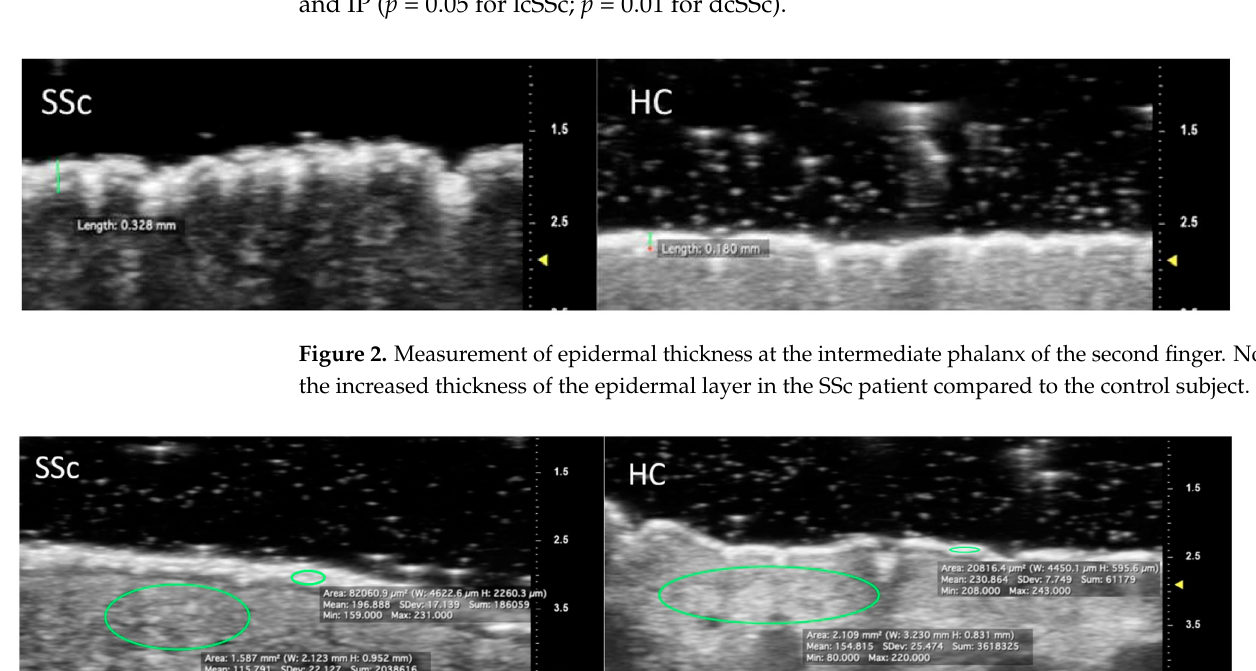
and IP ( p = 0.05 for lcSSc; p = 0.01 for dcSSc).